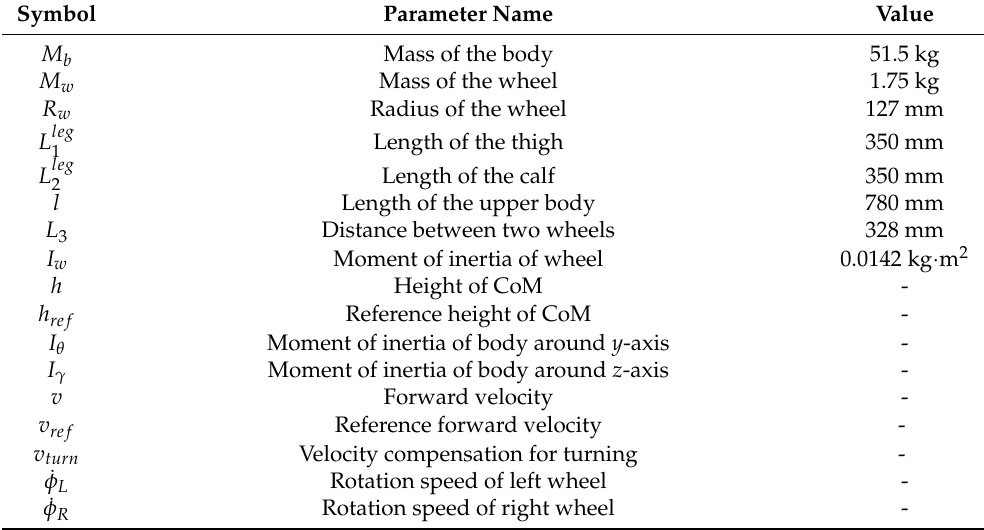
Table 2. Parameters of the upright balanced moving